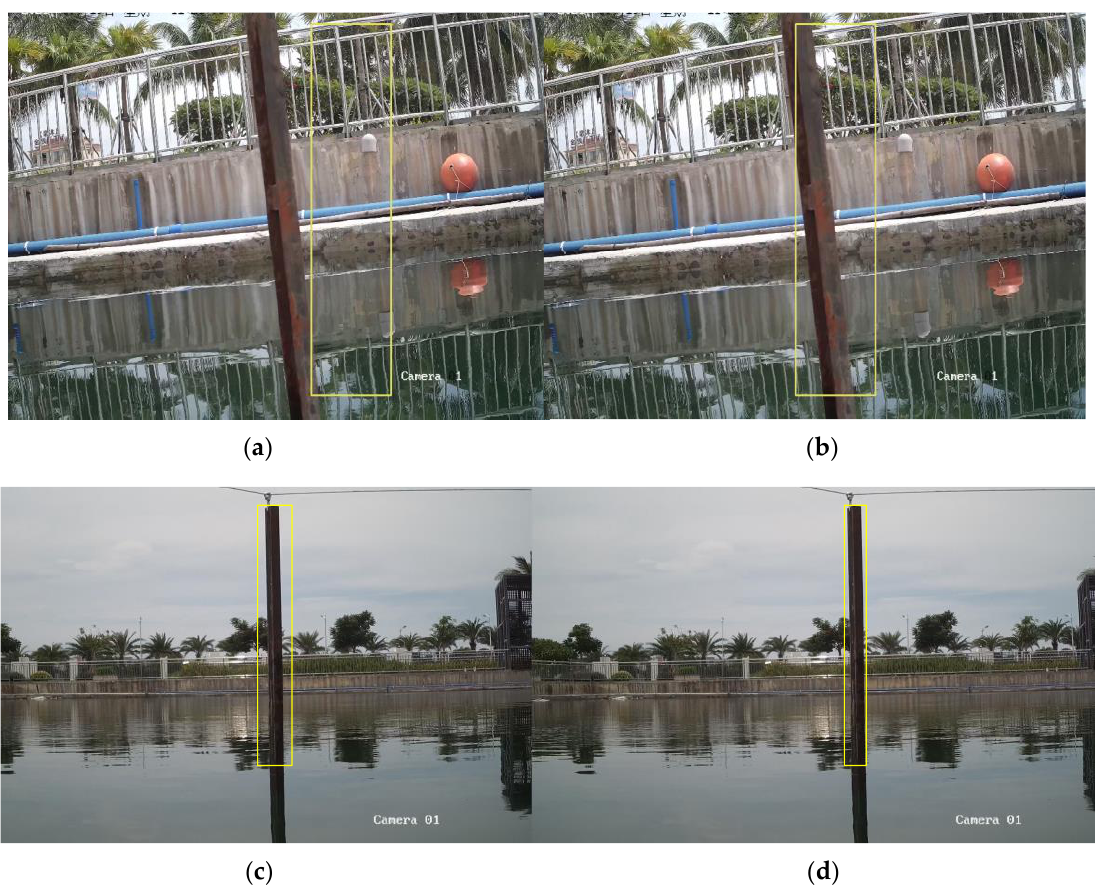
Figure 8. Target detection results with YOLOv3 and YOLO–Softer NMS: ( a ) near case with YOLOv3, ( b ) near case with YOLO–Softer NMS, ( c ) far case with YOLOv3, ( d ) far case with YOLO–Softer NMS.